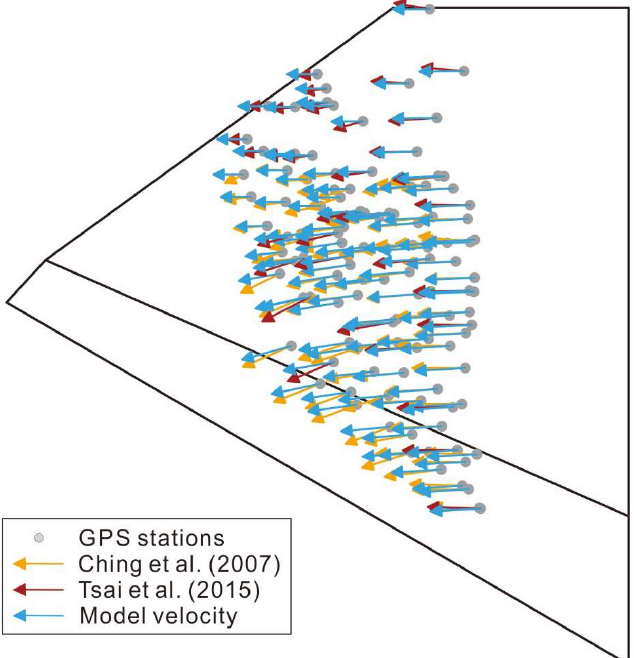
Figure 6. Model velocity and GPS velocity. Stations east of the Chaochou fault in the southern backbone range are not used here. The gray circles are the positions of the GPS stations. The yellow arrows are the horizontal velocity vectors reported by Ching et al. [4]. The red arrows are the horizontal velocity vectors reported by Tsai et al. [3]. The blue velocity arrows are the velocity vectors linearly interpolated from the model velocity field.